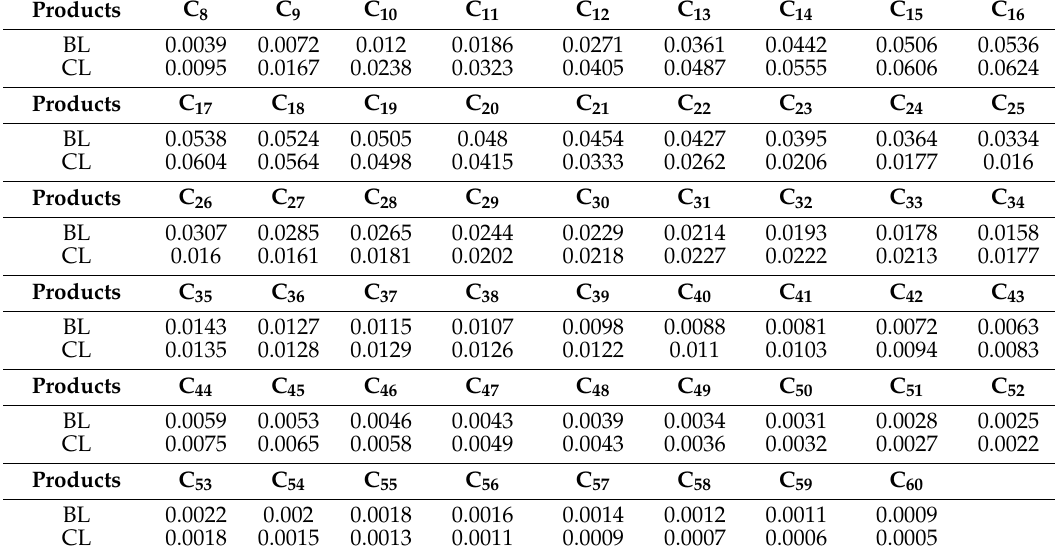
Table A3. Mass fraction of the FT products measured by off-line device